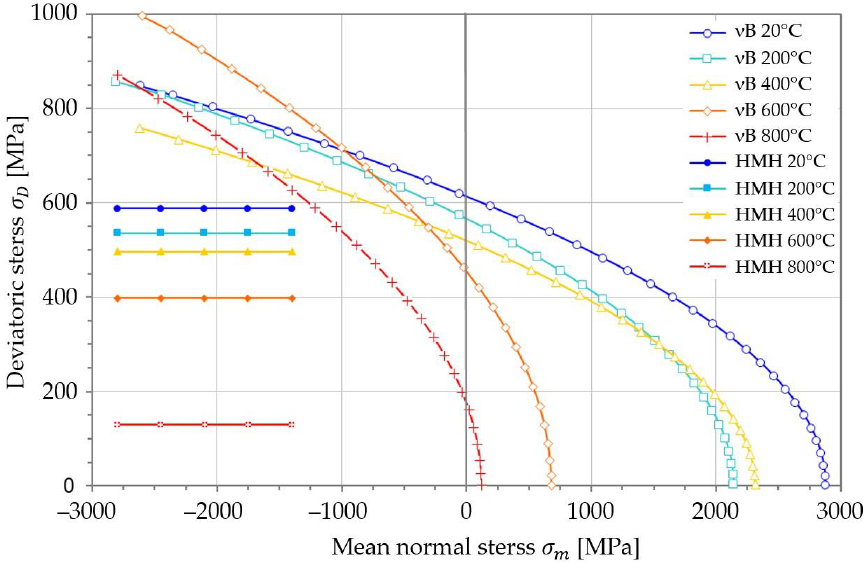
Figure 6. Comparison between HMH hypothesis and validated Burzyński hypothesis (vB) for St12T steel including a set of elevated temperatures [30].